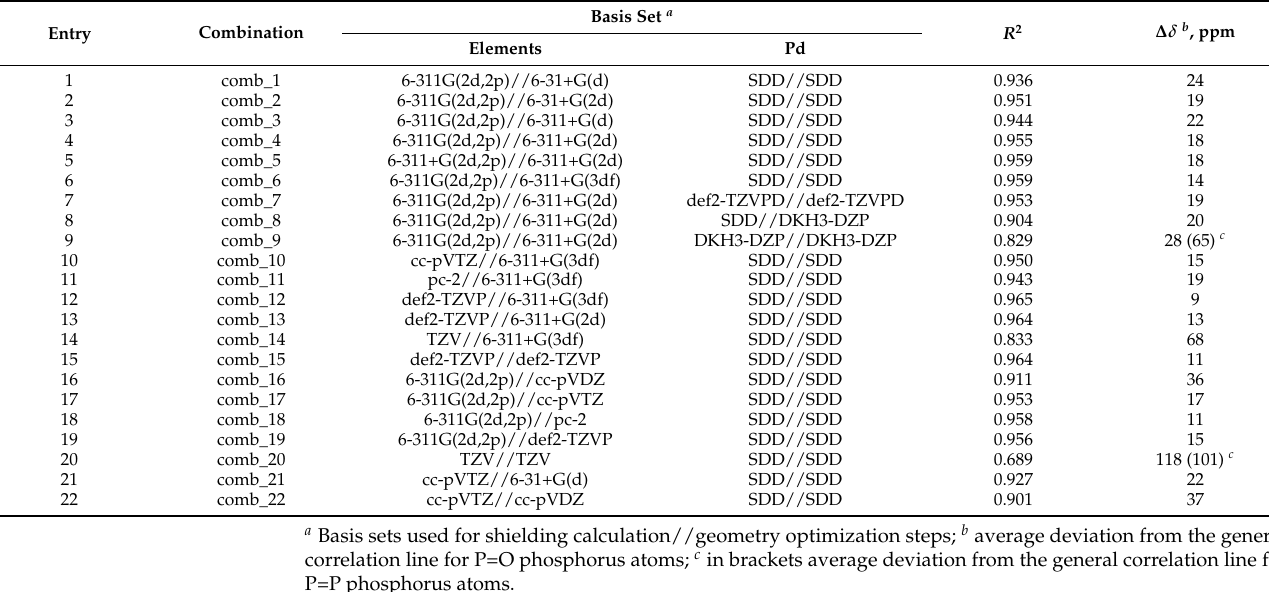
Table 1. R 2 dependence on combination used in the calculations for the “training” set of Pd complexes ( 2 , 9 , 17 , 22 – 23 , 26 , 28 – 30 , 32 , 38 ).